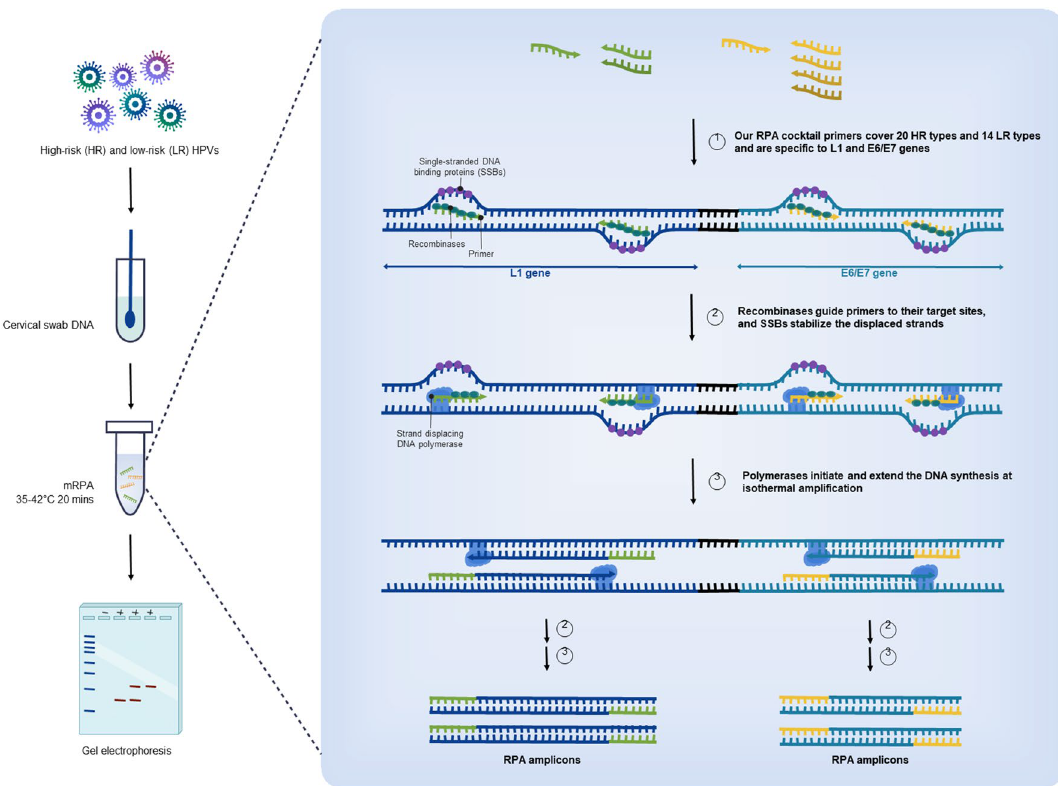
Figure 4. Schematic illustration of RPA and multiplex 2-gene amplification concepts for potential local applications.